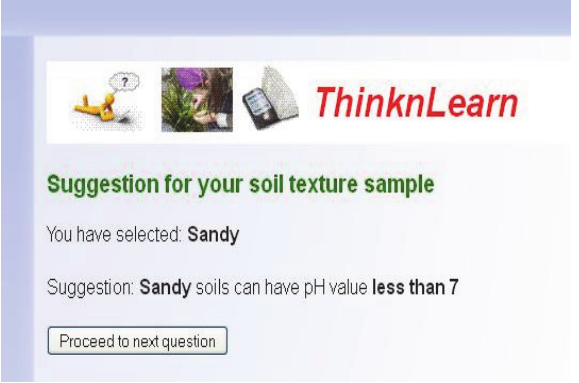
Figure 7 . Ontology extracts suggestions based on the chosen answer.